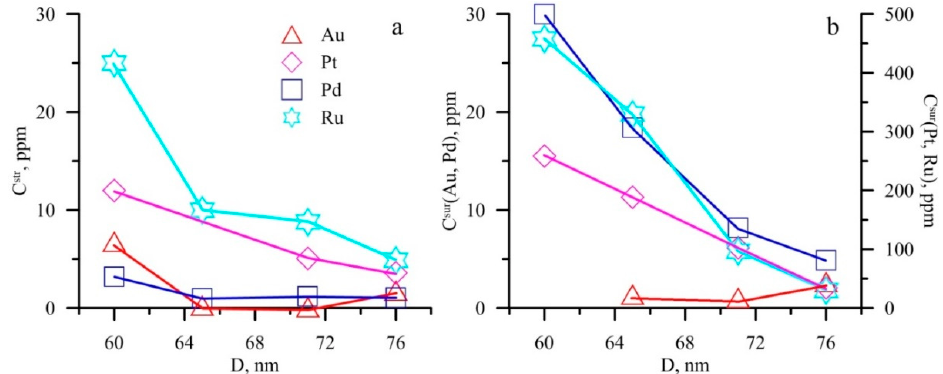
Figure 10. Dependences of noble metal (NM) contents in structurally ( a ) and superficially ( b ) bound modes on crystallite sizes in pyrite crystals. See Tables 3 and 4 for numerical data.